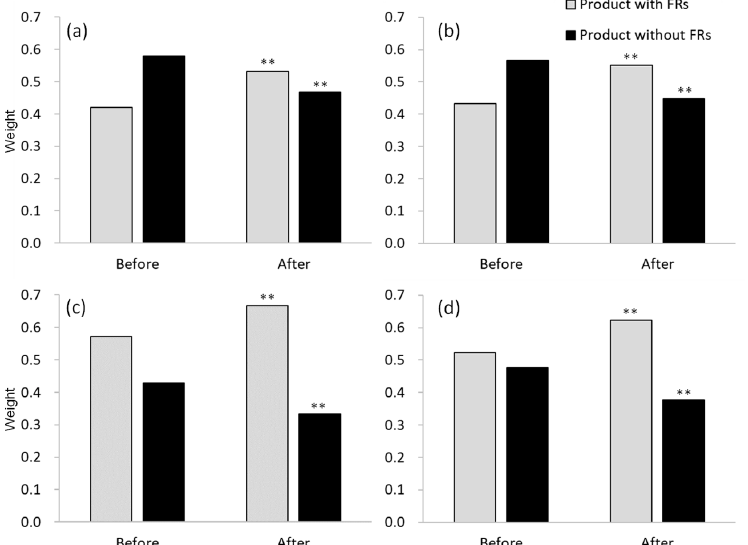
Figure 6. Weights of product alternatives by evaluation criteria: ( a ) Health; ( b ) Environment; ( c ) Safety; ( d ) Cost (left: before watching video; right: after watching video). Two-sided test, alternative hypothesis: “before watching video” ≠ “after watching video”, ** p < 0.01.